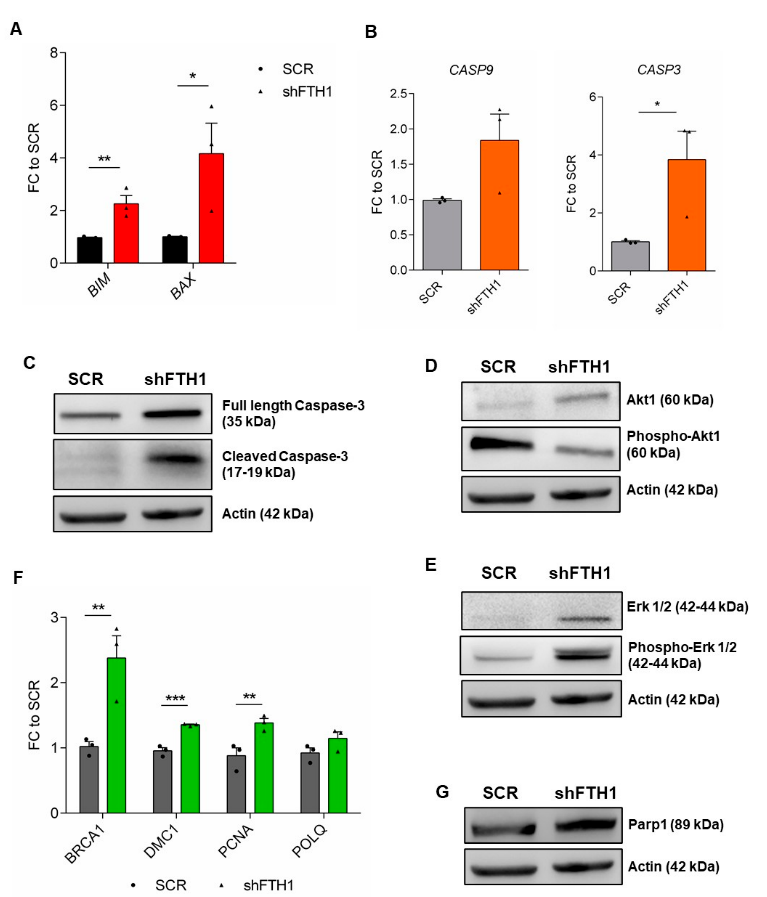
Figure 4. FTH1 silencing leads to expression of apoptosis and DNA damage markers in hESCs. ( A , B ) qRT-PCR for apoptosis-associated genes BIM and BAX ( A ) and CASP3 and CASP9 ( B ) showing increased expression levels of apoptotic marker in FTH1-KD hESCs compared to SCR control; ( C ) Activation of apoptotic signaling in FTH1-KD hESCs is demonstrated also by immunoblot analysis for full length and cleaved form of caspase-3; ( D ) Western blot analysis of Akt1 and phosphorylated Akt1 (Ser473, pAkt) protein expression; ( E ) Immunoblot for total Erk1/2 and phosphorylated Erk1/2 (Thr202/Tyr204, pErk1/2) in SCR control and FTH1-KD hESCs; ( F ) qRT-PCR analysis for DNA damage related genes ( BRCA1 , DMC1 , PCNA , POLQ ) in control and silenced hESCs; ( G ) Western blot analysis for Parp1 protein expression in SCR and FTH1-silenced cells. For all Western blots shown, actin levels were evaluated as loading control. Results of qRT-PCR were normalized to measurements in SCR cells ( n = 3); * p ≤ 0.05; ** p ≤ 0.01, t -test, *** p ≤ 0.001. Small dots refer to SCR replicates, while triangles refer to shFTH1